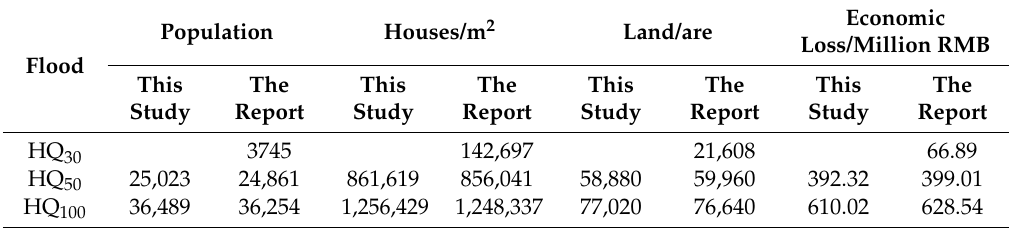
Table 1. The physical indicators and economic losses in floods of different return periods.